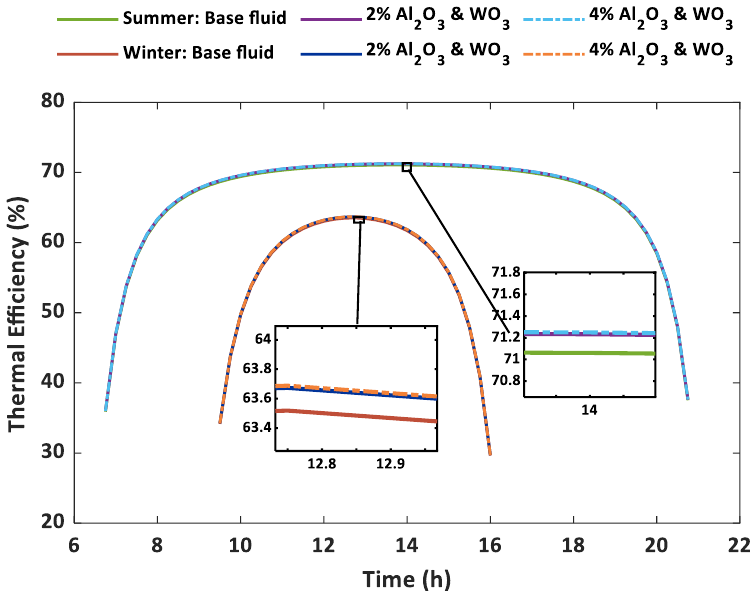
Figure 13. Thermal efficiency of the base fluid and HNFs for sunny and winter days in Budapest.